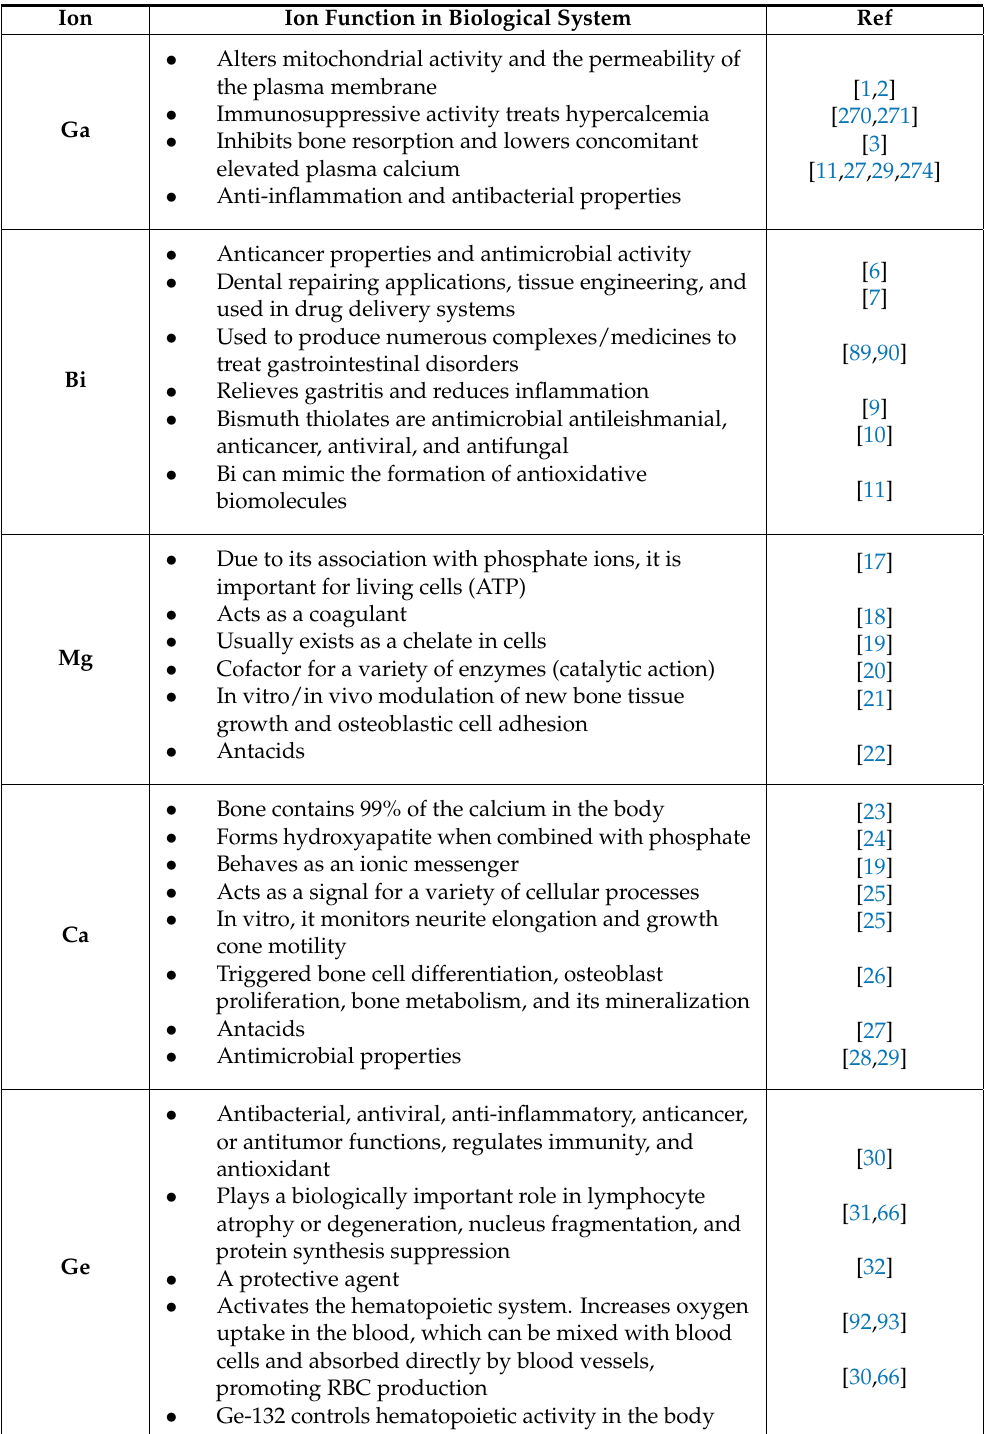
Table 2. Review of the list of metallic ions along with their potential biological